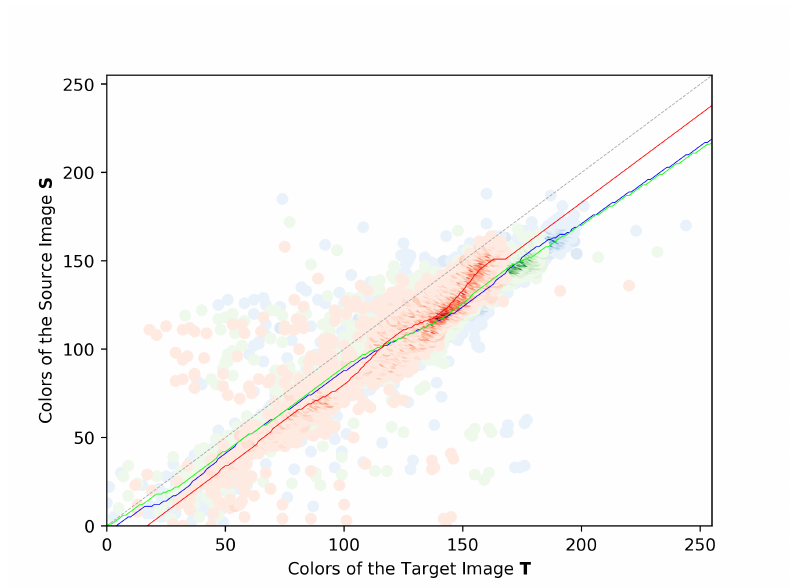
Figure 6. Example of the estimation of three Color Mapping Functions, one for each